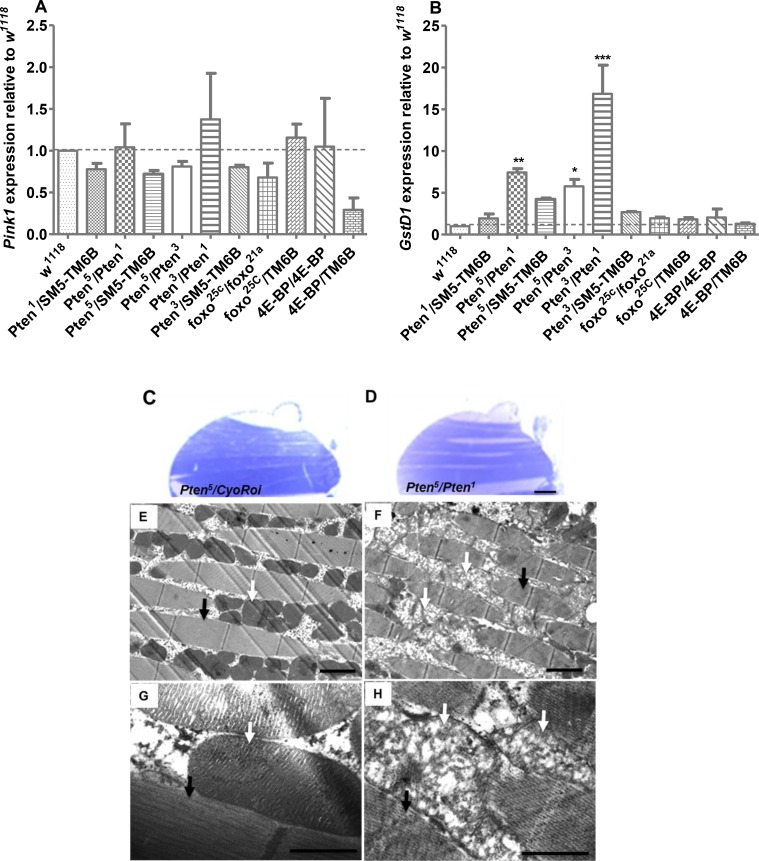
Transheterozygous Pten
5 mutants exhibit defects in mitochondrial structure in IFM and upregulation of the oxidative stress response gene, GstD1.(A) qRT-PCR of Pink1 mRNA expression levels in third instar larvae carrying different mutations affecting IIS/mTORC1 signalling normalised to wild type w
1118 control animals. (B) Levels of the anti-oxidative enzyme-encoding GstD1 transcript are elevated significantly in Pten mutant backgrounds compared to w
1118 controls. However, there is no significant modulation in the transcript expression levels of GstD1 in either foxo or 4E-BP mutants or Pten heterozygous animals. Data are presented as mean ± SEM. * P <0.05; ** P < 0.001; ***P < 0.0001, and are from three independent experiments. Significance was determined by one-way ANOVA with Bonferroni post-hoc correction test. (C-H) Longitudinal sections of thoraces of 26-day-old female flies either stained with toluidine blue and visualized by light microscopy (scale bar: 100μm; C,D) or imaged by transmission electron microscopy (TEM; scale bar: 1μm) to visualize ultrastructure of IFMs (E-H). The sarcomeric structure of mutant muscle appears relatively normal (black arrows in F,H compared to controls in E,G), but mitochondrial morphology in the mutant is severely disrupted (white arrows in F,H compared to controls in E,G).